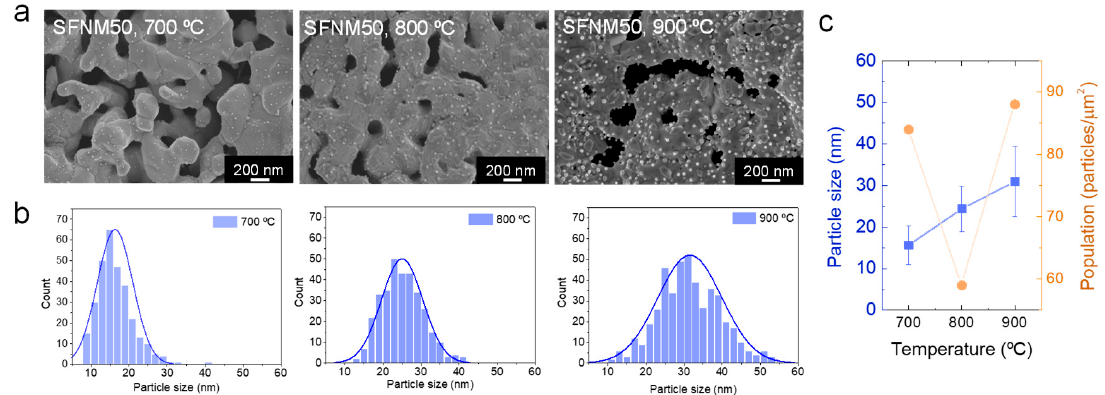
Figure 6. Influence of exsolution temperature on the particle size and population. ( a ) SEM images of SFNM50 material after exsolution at 700, 800, and 900 °C during 2 h in a 5% H 2 atmosphere. ( b ) Particle size distribution histograms. ( c ) Particle size and population versus temperature.